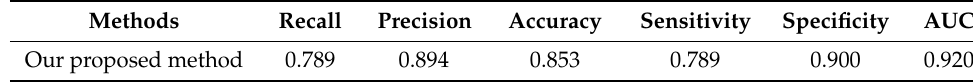
Table 2. The results fracture classification of detected scaphoid.